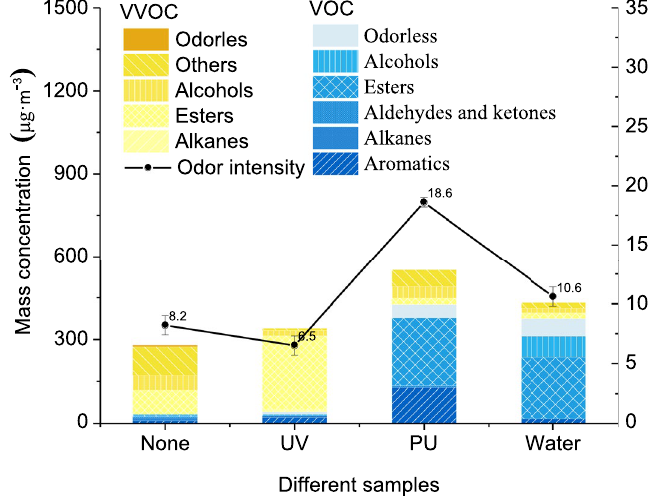
Figure 3. Concentrations of VOC/VVOC components and total odor intensity from Xylosma racemosum (Sieb. et Zucc.) Miq. with different lacquer